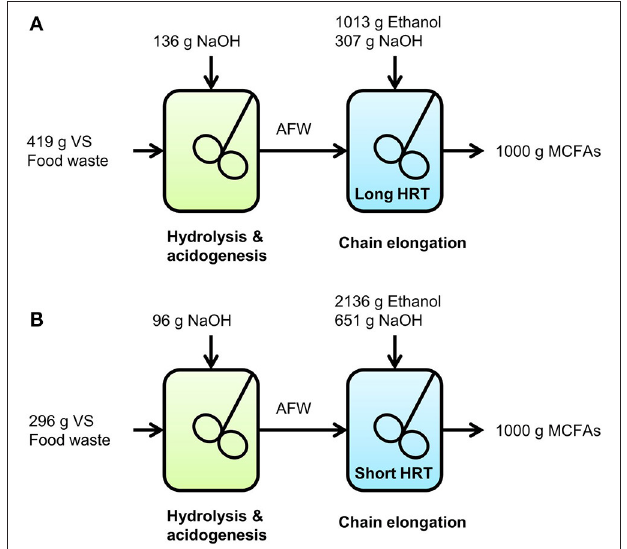
FIGURE 2 | Graphical representation on how much food waste (g VS), ethanol and NaOH would be consumed to yield 1,000g MCFAs in the two-stage system at long HRT (A) and at short HRT (B) in the chain elongation